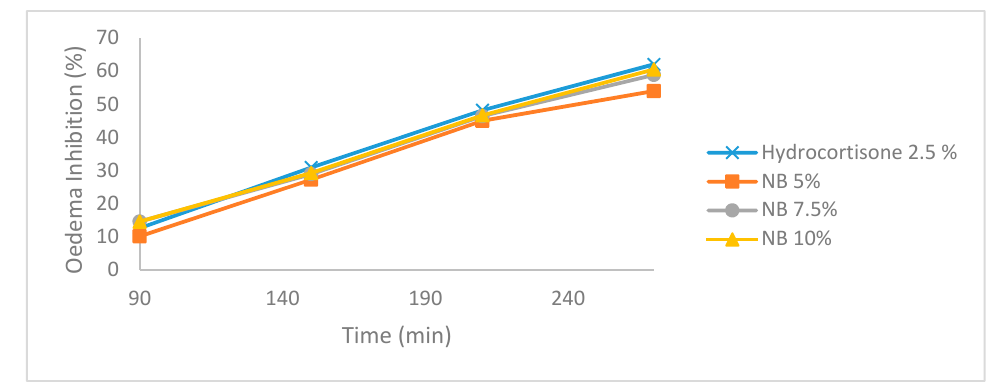
Figure 2 . Oedema inhibition percentage of paw edema. Figure 2. Oedema inhibition percentage of paw edema.